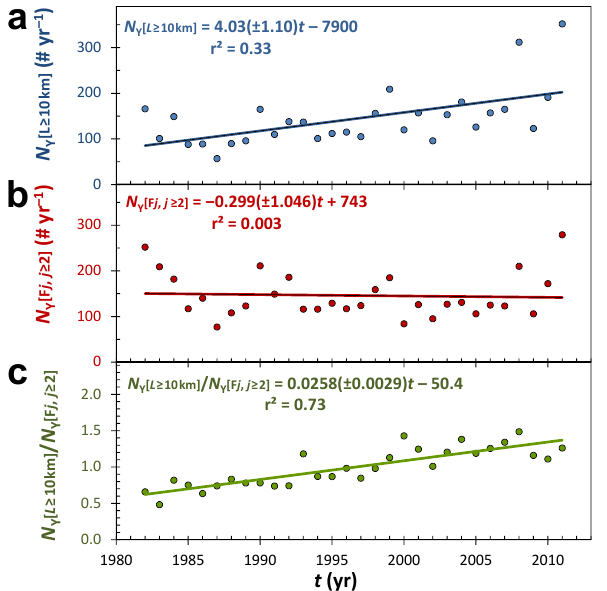
Fig. 7. Continental USA number of severe tornadoes per year, N Y , over the time period 1982–2011, using two definitions for severe tornadoes, one path-length based and the other Fujita scale inten- sity based. Shown are the total number per year of (a) severe tor- nadoes ( L ≥ 10km), N Y [ L ≥ 10km ] (F0 to F5 considered), (b) se- vere tornadoes with Fujita (or Enhanced Fujita) scale intensities greater than or equal to F2, N Y [ F j,j ≥ 2 ] , (all path lengths L con- sidered). In (c) is shown, per year, the ratio of (a) to (b) , i.e. N Y [ L ≥ 10km ] /N Y [ F j,j ≥ 2 ] . In all three panels, the best-fit linear cor- relations are shown, with uncertainties given as ±1s.e. (standard error) of the slope. Tornado path length data L are from NOAA (2012).